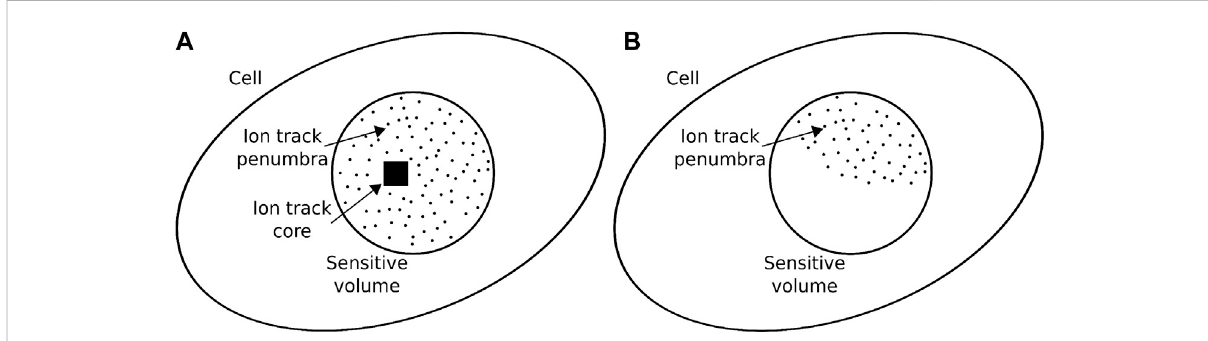
FIGURE 1 Twoexamplesofintersectionoftheiontrackwiththecell ’ ssensitivevolume.Theionmayhitdirectlythesensitivevolume (A) ,inwhichcasethe corevolumeisinside thesensitive volumeandthus ( V ) p (cid:1) V s − ( V ) c .Thecore crosssectionwassetasasquare forthesakeofcomputing simplicity. If the ion does not hit the sensitive volume (B) , then ( c k V ) c (cid:1) 0. The representation is not to